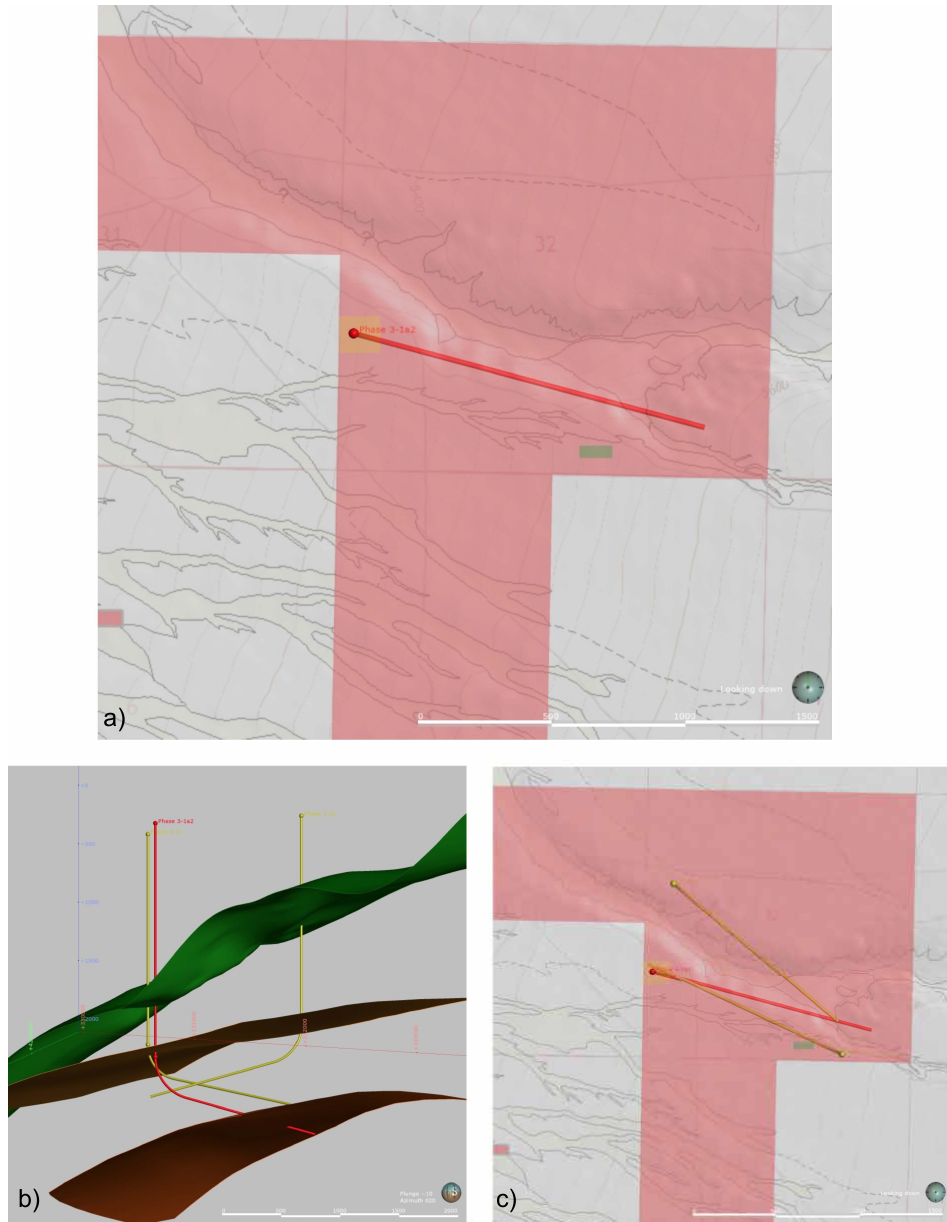
Figure 15. Map view of the FORGE site (red shaded area) showing the proposed trajectory for the first Phase 3 well ( a ); oblique cross-section view that shows the top of the granite surface (green); 175 ◦ C and 225 ◦ C isosurfaces and several previously evaluated trajectories ( b ); and a map view showing several previously evaluated trajectories (yellow lines) and the recommended trajectory (red line) ( c ). Scale bar on top figure represents 1500